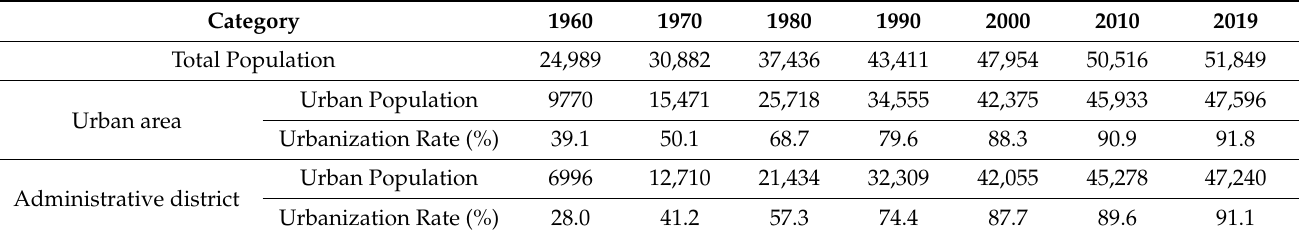
Table 3. Trends of urbanization rates of South Korea